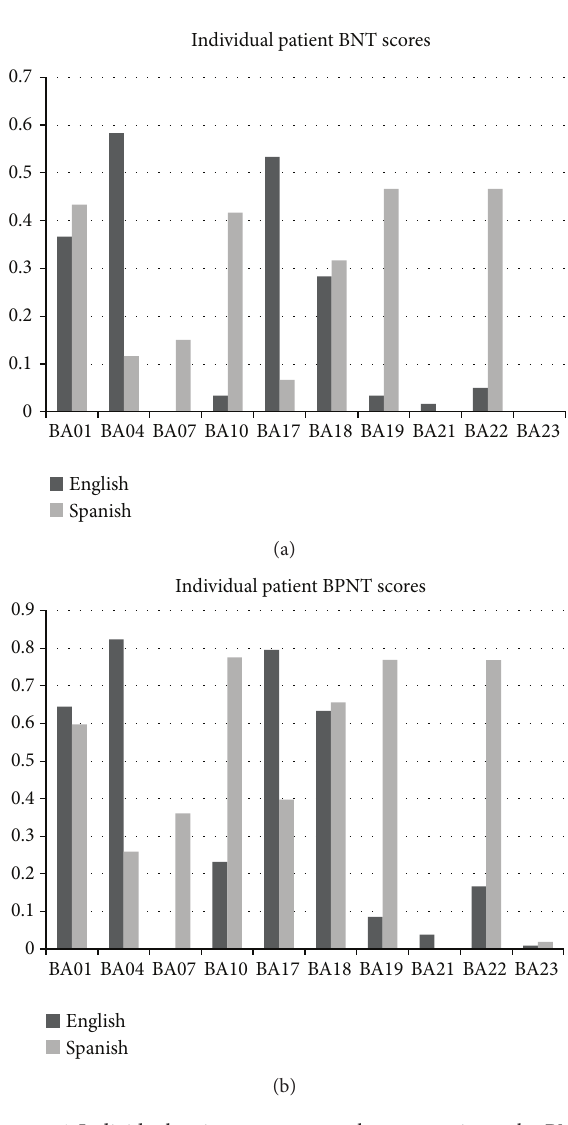
Figure4:Individualpatientaccuracyonthetwonamingtasks:BNT (a) and BPNT (b) in English and Spanish.